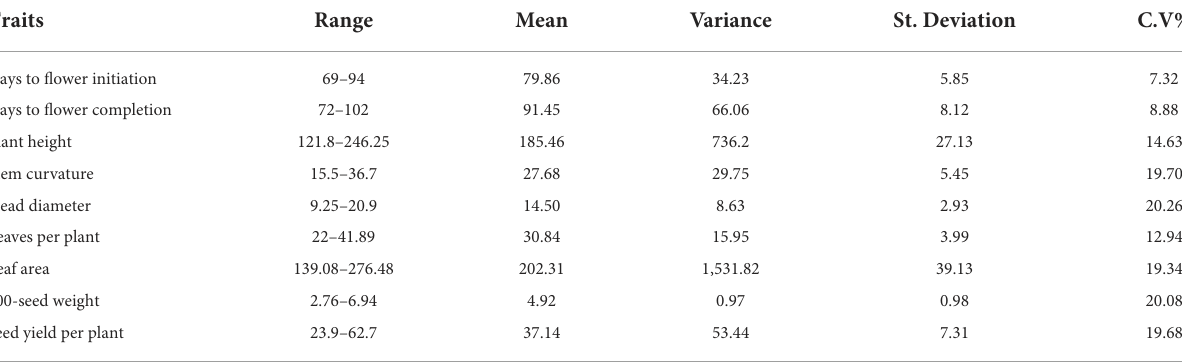
TABLE 1 Range, mean, variance, standard deviation, and coefficient of variation (%) of nine morphological traits.